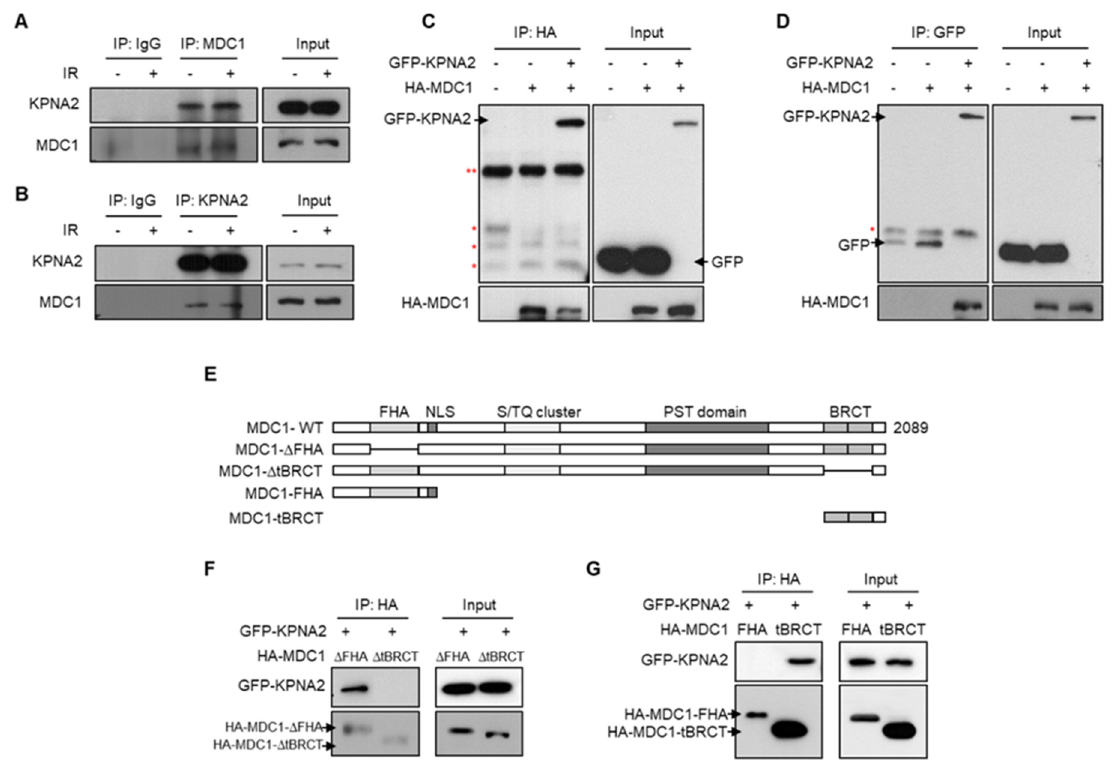
Figure 1. KPNA2 interacts with two BRCA1 carboxyl-terminal (tBRCT) domain of mediator of DNA damage checkpoint protein 1 (MDC1). ( A,B ) HeLa cells, with or without exposure to ionizing radiation (IR), and whole-cell lysates were subjected to immunoprecipitation using an anti-MDC1 ( A ) or anti-KPNA2 ( B ) antibodies, followed by Western blotting using antibodies against either KPNA2 or MDC1. ( C,D ) HA-MDC1 and GFP-KPNA2 were co-transfected into HEK293T cells and exposed to IR. Whole cell lysates were subjected to immunoprecipitation using anti-HA ( C ) or anti-GFP ( D ) antibodies, followed by Western blotting using antibodies against either HA or GFP. *, nonspecific band. **, IgG heavy chain band. ( E ) Schematic representation of domain structure of wild-type MDC1 and the various deletion mutations is shown. ( F , G ) GFP-KPNA2 were transfected into HEK293T cells along with indicated deletion mutants of MDC1 ( F ) or HA-MDC1-FHA and HA-MDC1-tBRCT ( G ). Cell lysates were immunoprecipitated using anti-HA antibody and analyzed by Western blotting using the indicated antibodies.